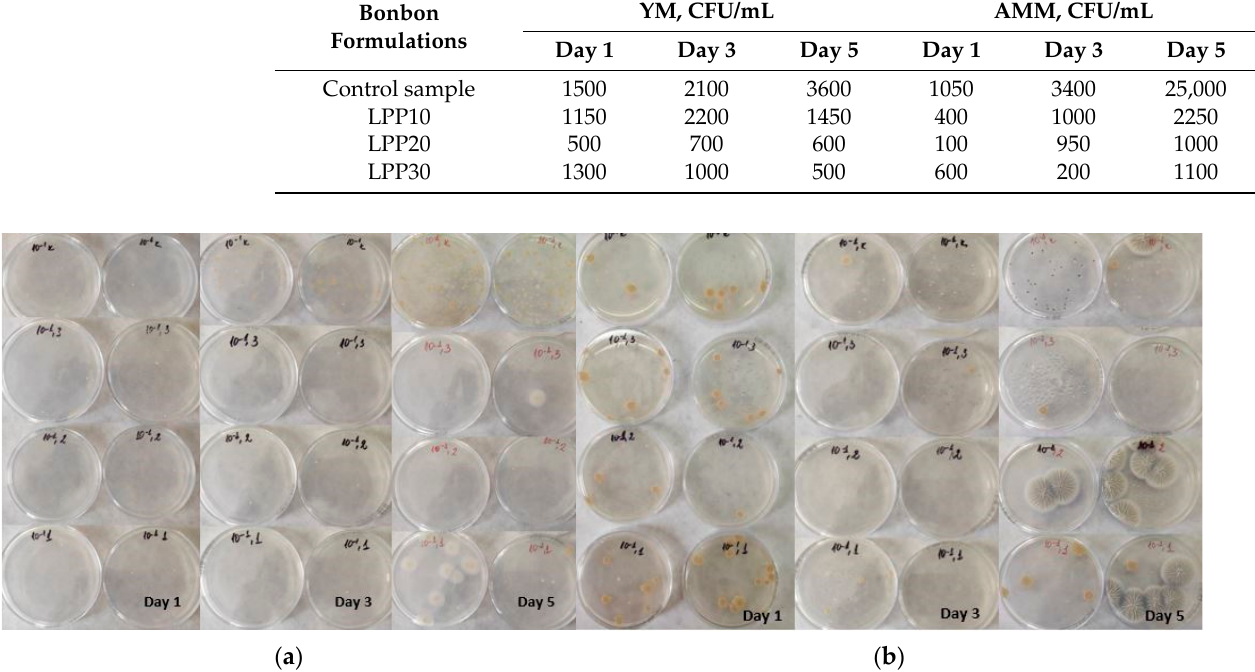
Figure 4. View of microbial growth in bonbon formulations: ( a ) AMM; ( b ) YM.